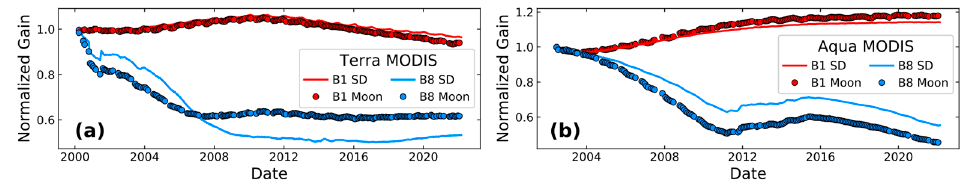
Figure 3. ( a ) Terra and ( b ) Aqua MODIS SD and Lunar gain trending for bands 1 and 8.